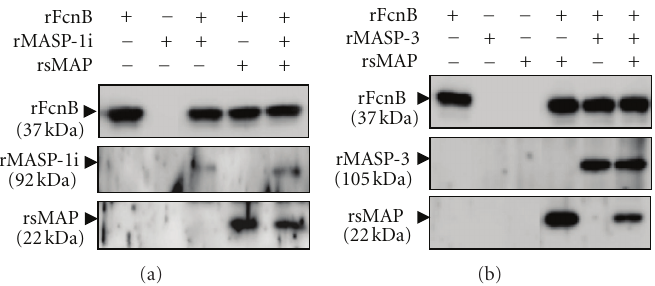
Figure 5: Complex formation between rFcnB and rMASP-1i (a) and rMASP-3 (b). After incubation of the recombinant proteins as outlined in the table, samples pulled down with GlcNAc agarose were subjected to western blotting. Western blotting for rMASP-1i, rMASP-3, and rsMAP was performed using an anti-penta-His tag